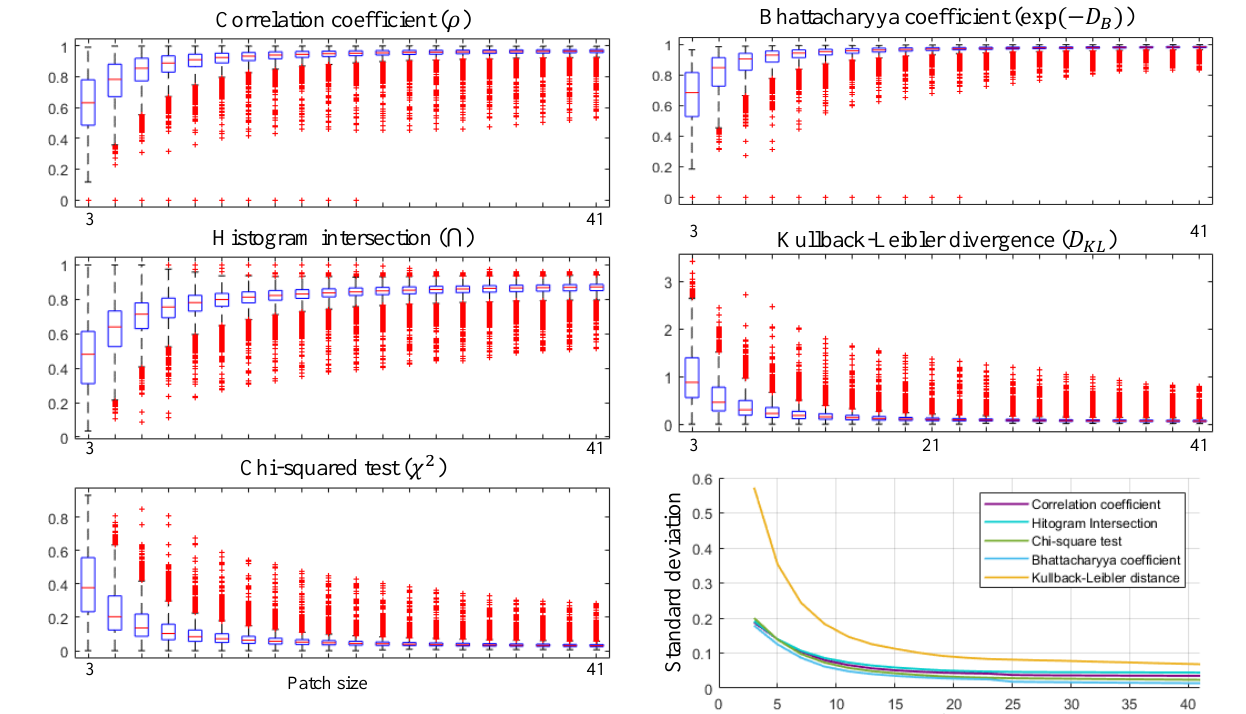
Figure 6. Experiment for deciding the optimal patch size. The interquartile range (IQR) and standard deviation were utilized to derive the appropriate condition for the properties of the LWIR image. A total of 4000 patches were randomly sampled from the datasets for each patch size. In this study, size of 21 × 21 has been empirically decided as the optimal patch size. IQRs of five measures with respect to increasing patch size are demonstrated. IQRs of each patch size were calculated based on the randomly sampled 4000 patches. Standard deviation with respect to increasing patch size is also